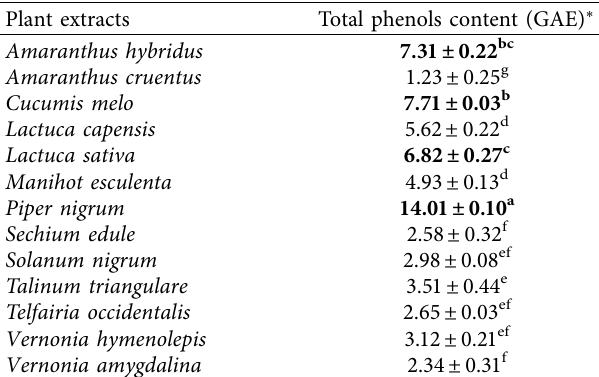
Table 3: Total phenol content of the methanol extracts of thirteen antibacterial edible